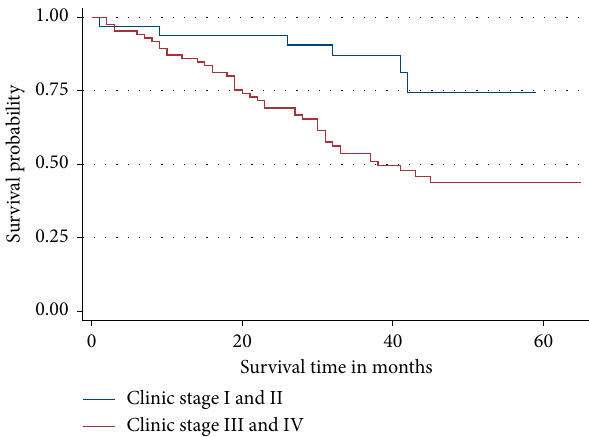
Figure 4: Overall survival by clinical stage. The risk of dying was increasing with progression of the disease.